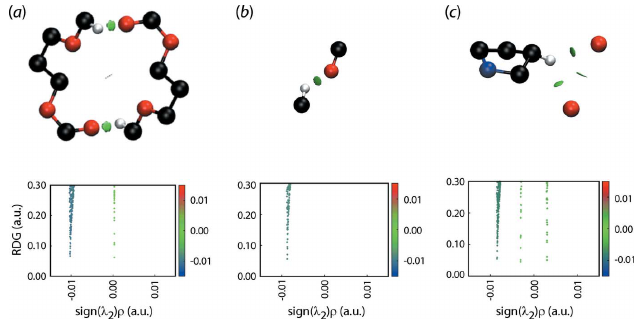
Figure 3 Non-covalent interaction plots for the following interactions in (II): ( a )